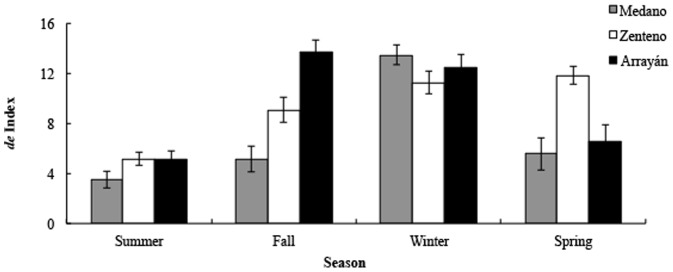
Mean and standard error of the de index.